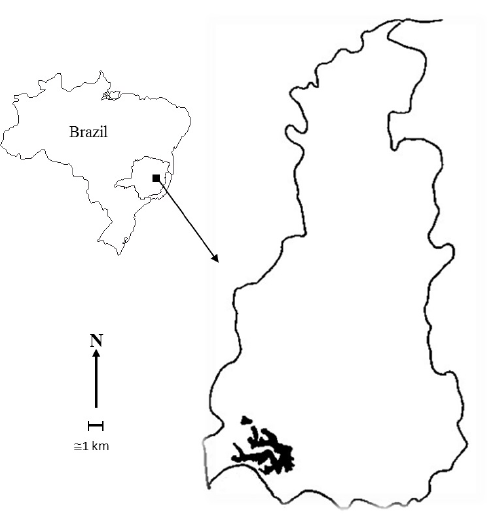
Figure 1. Carioca and Dom Helvécio lakes, southeast